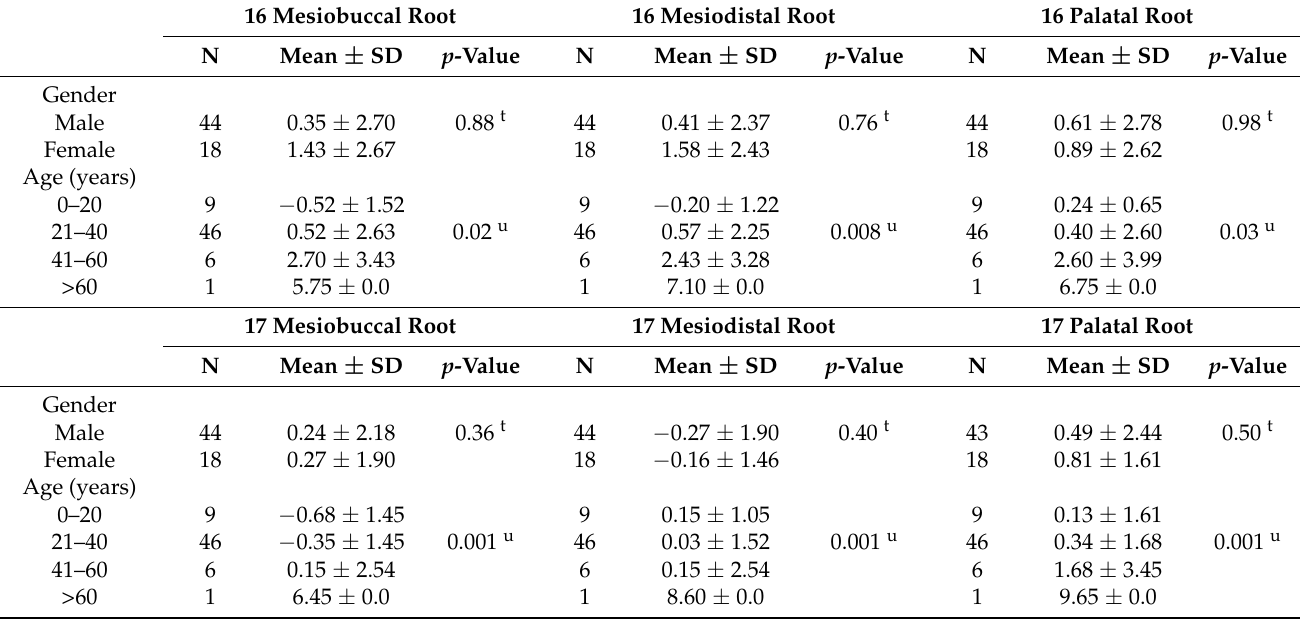
Table 5. Measurements of distances (mm) between apices of right 1st and 2nd molar roots and floor of the maxillary sinus concerning age and gender ( n =